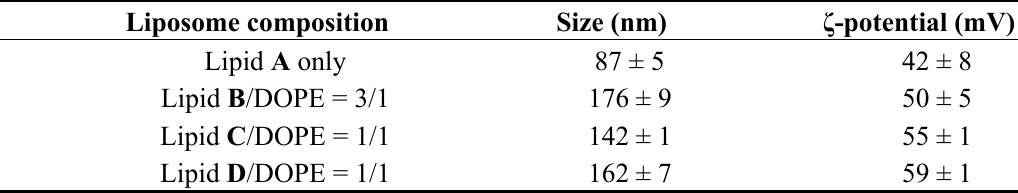
Table 1. Size and ζ -potential of